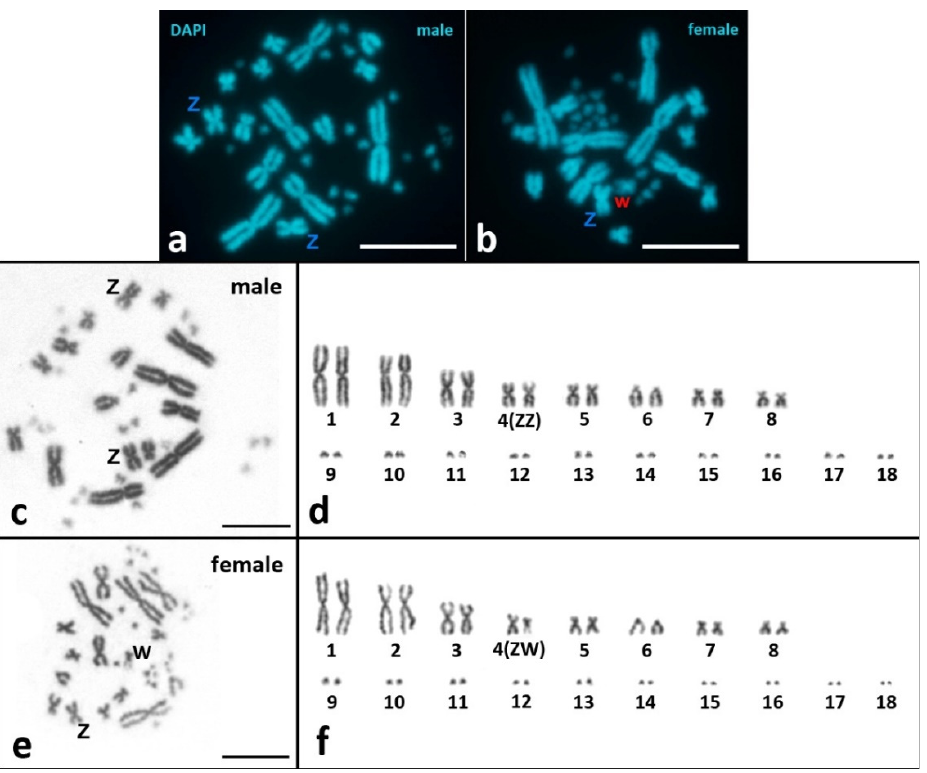
Figure 1. Mitotic karyotypes of V. berus . ( a , b ) DAPI staining and ( c – f ) conventional Giemsa staining. ( a , c , d ) Male karyotypes; ( b , e , f ) Female karyotypes. ( a – c , e ) Metaphase chromosome plates; ( d , f ) karyograms. ZZ/ZW—sex chromosomes. Scale bar—10 μ m.